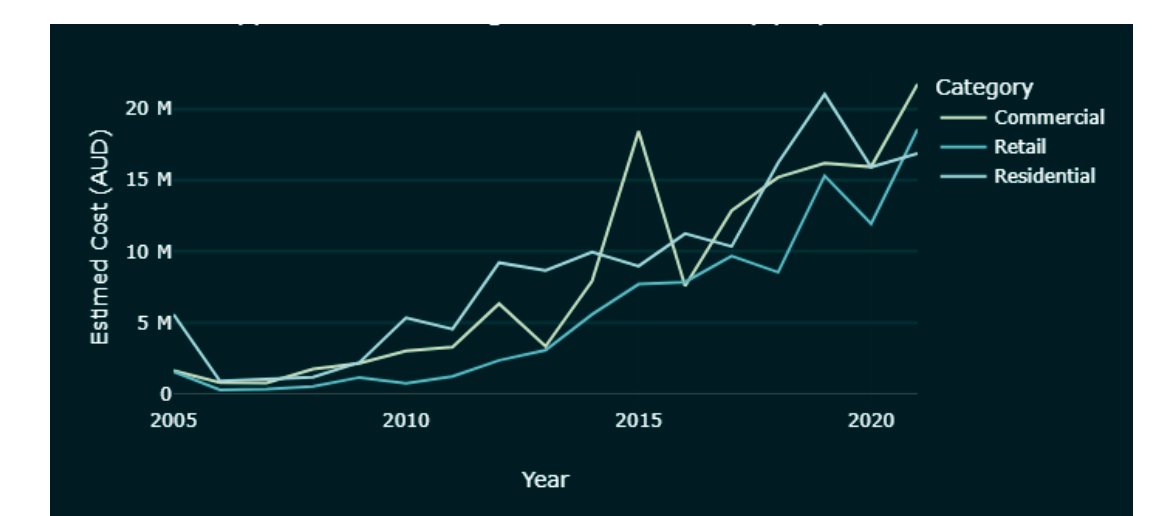
Figure 36. Average estimated cost of approved DAs by proposed uses over time (2005–2021).